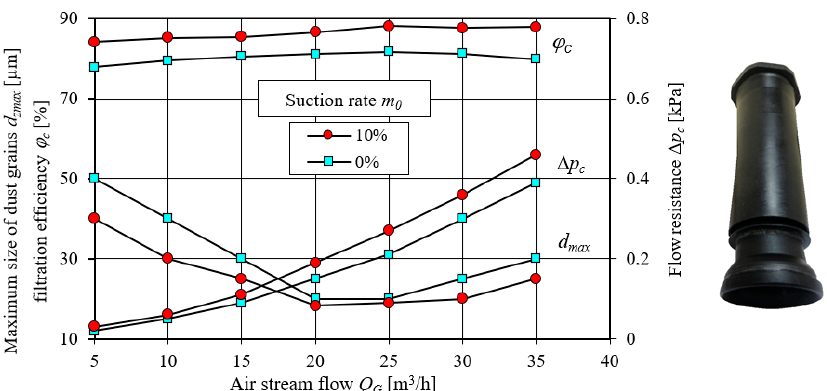
Figure 11. The characteristic of the filtration efficiency ϕ c = f ( Q G ) and the flow resistances ∆ p c = f ( Q G ) of the pass-through cyclone filter of the Volvo truck with dust suction ( m 0 = 10%) and without any dust suction.